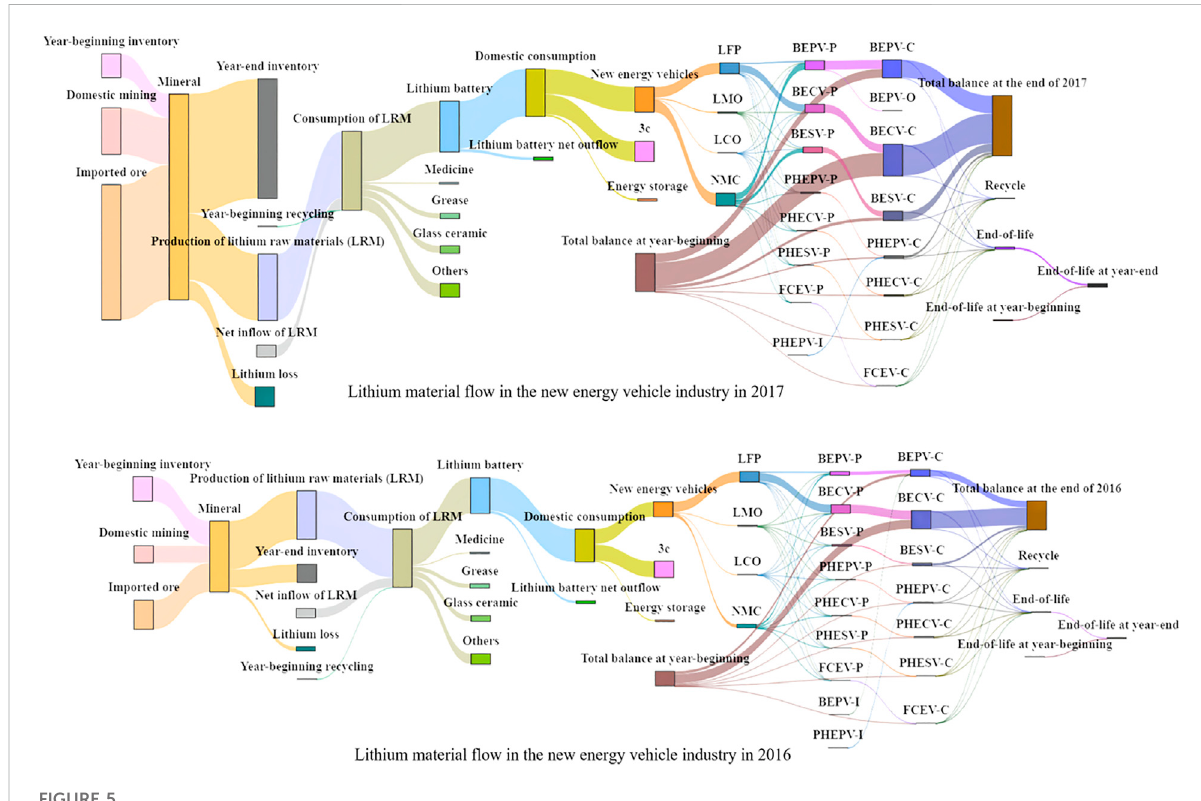
FIGURE 5 Lithium material fl ow in the new energy vehicle industry in 2016 –